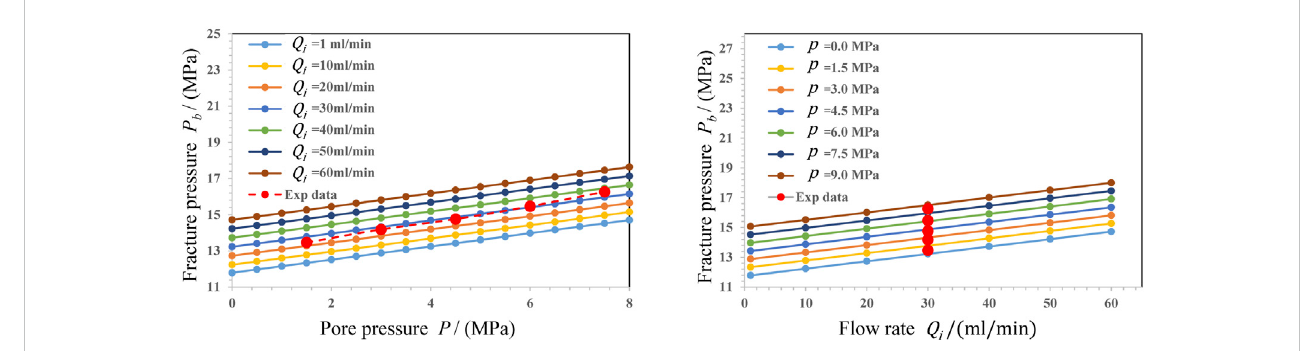
FIGURE 10 In fl uence regularity of the pumped fl ow rate Q i on the fracture pressure P b .